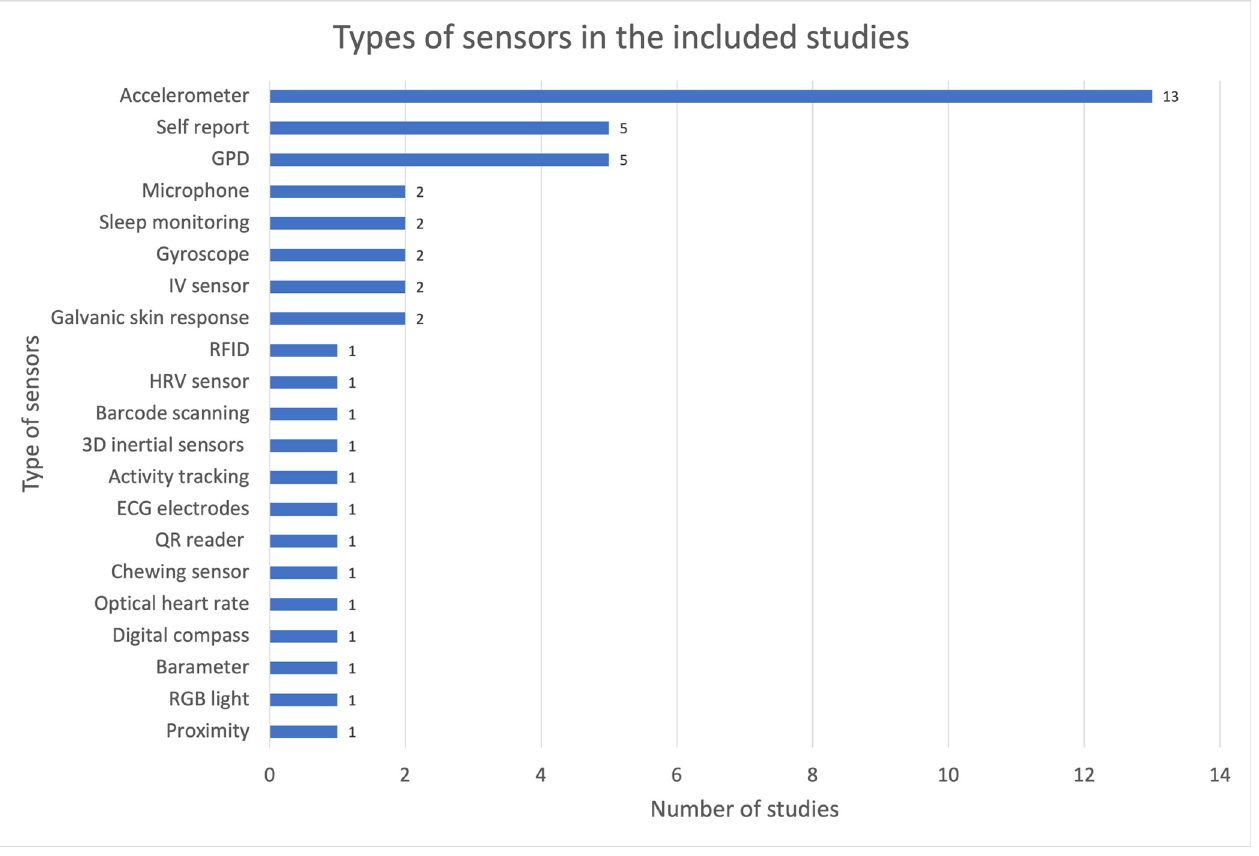
Fig 3. Sensors in included studies ��